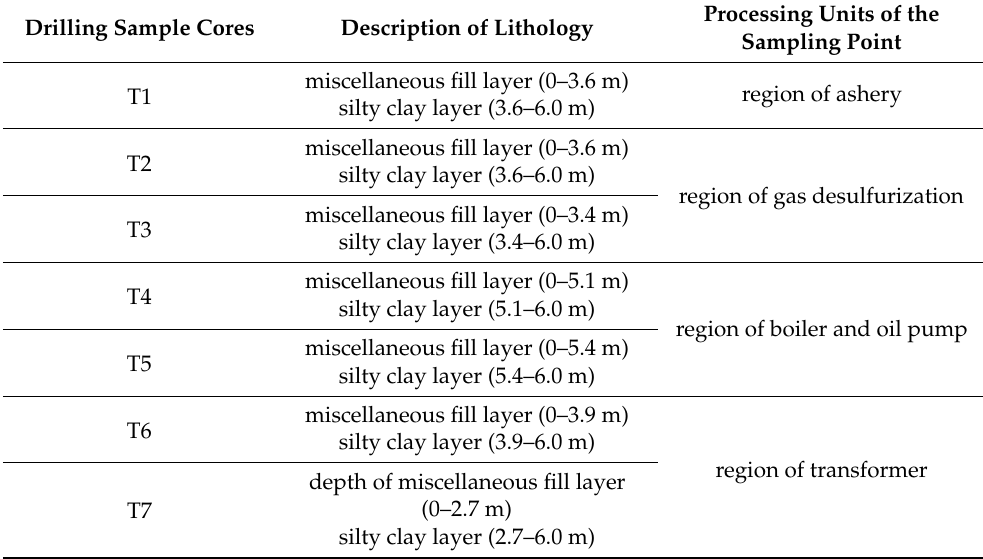
Table 1. Lithology and location information of 7 core samples sites. Drilling Sample